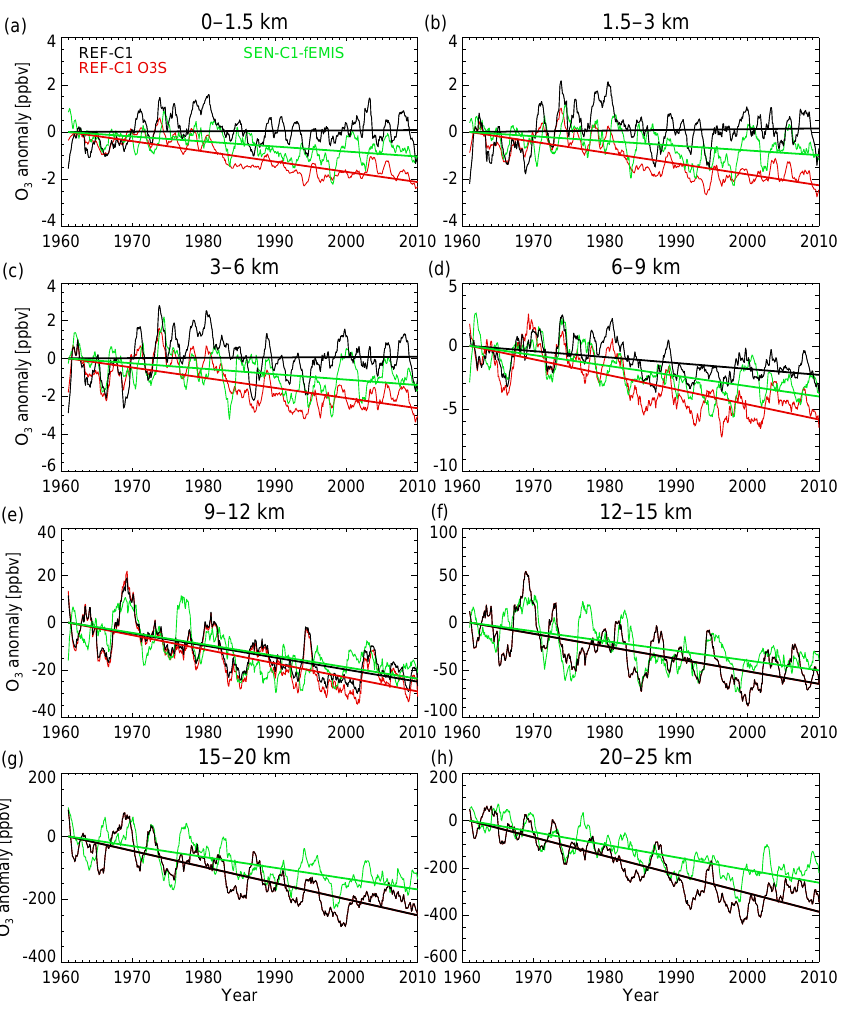
Figure 9. Modelled O 3 anomalies and linear trends at Lauder over 1960–2010 from REF-C1 (black) and SEN-C1-fEMIS (green), re- spectively. The anomaly and linear trend of stratospheric O 3 tracer (O 3 S) are also depicted (red). Anomalies shown are smoothed with a 13-monthly filter for the purpose of